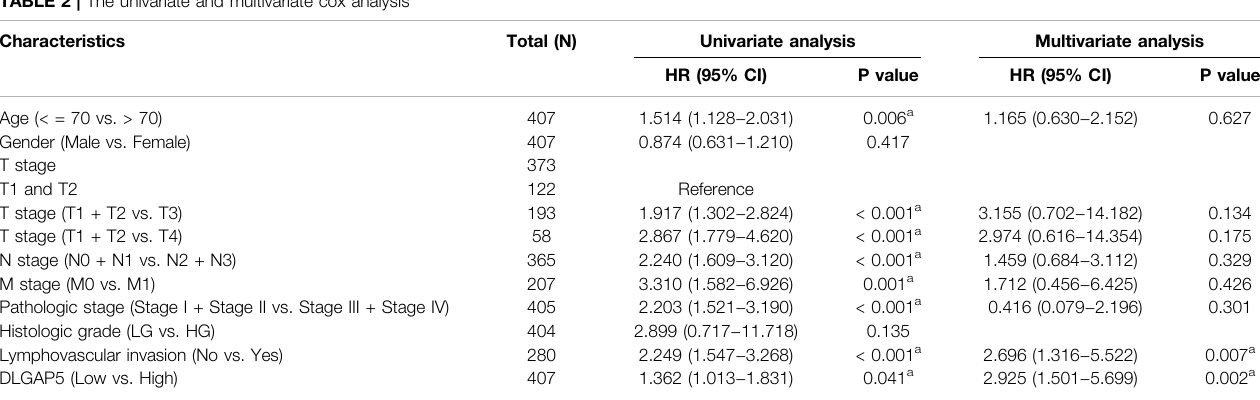
TABLE 2 | The univariate and multivariate cox analysis Characteristics Total (N) Univariate